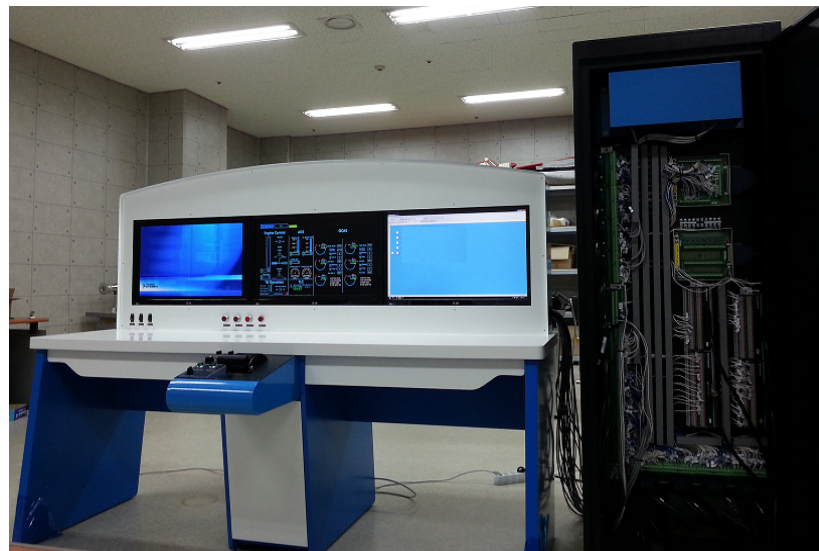
Figure 7. Test bench integration. Table 2. Required specification of test bench.